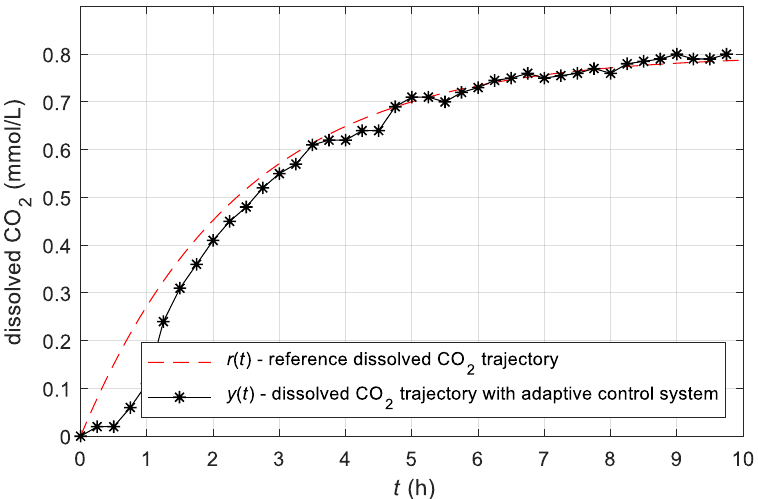
Figure 13. Time responses of the reference and actual dissolved CO 2 profiles obtained with the experiment where the simple adaptive control was used for control of fermentation process of laboratory batch bioreactor with fully activated kefir grains.